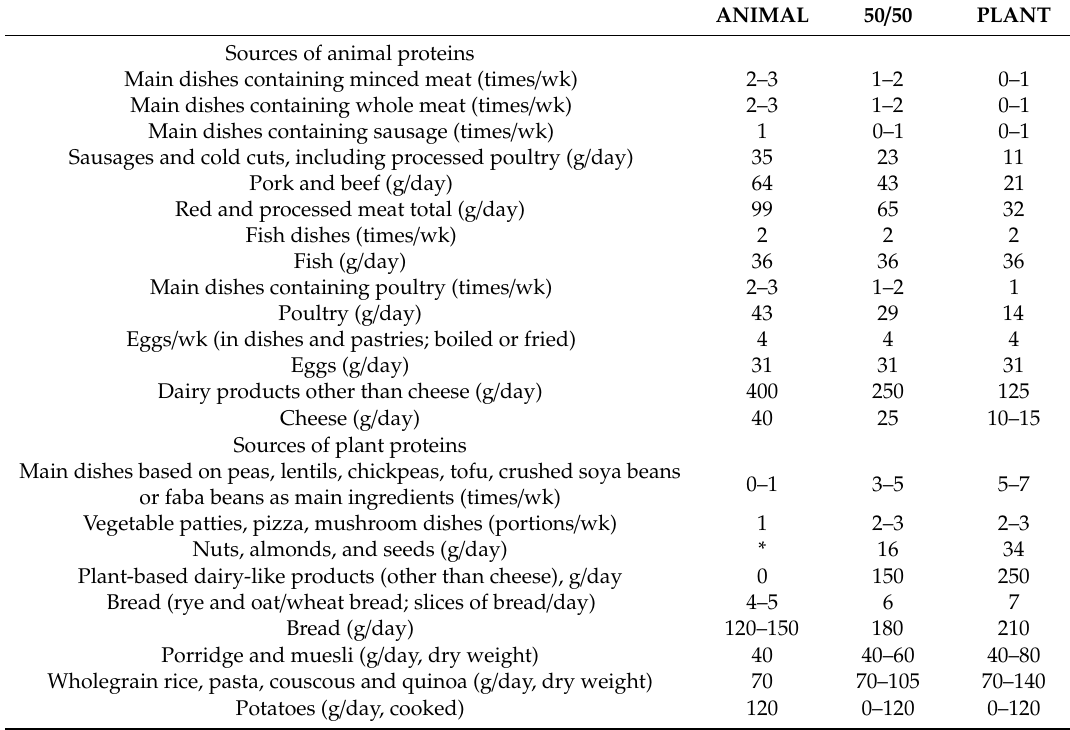
Table 1. Consumption frequencies and daily consumption of specific foods and food groups in the intervention diets based on the delivered food items and diet instructions. Average daily consumption is presented as g /